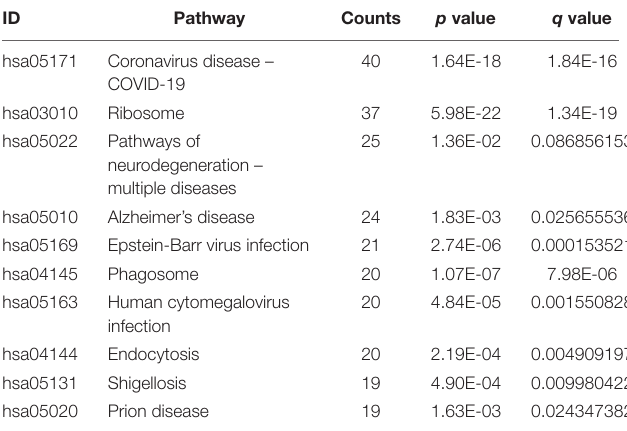
TABLE 3 | The KEGG pathway for the